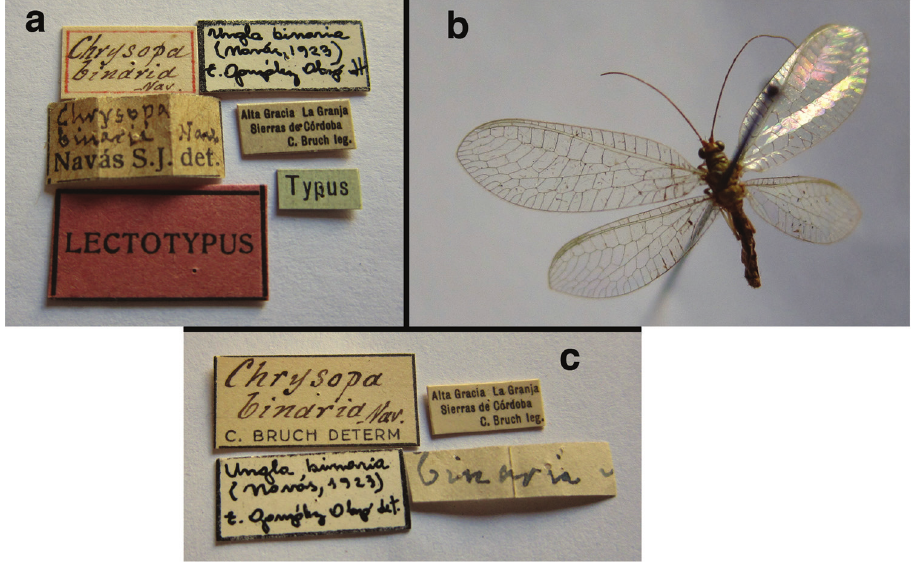
Figure 125. Chrysopa binaria Navás: ( a ) labels from paralectotype ( b ) habitus of female paralectotype, dorsal ( c ) labels of nontype specimen, from type locality, and determined by C. Bruch, collector of the lectotype (all: Argentina, Córdoba,